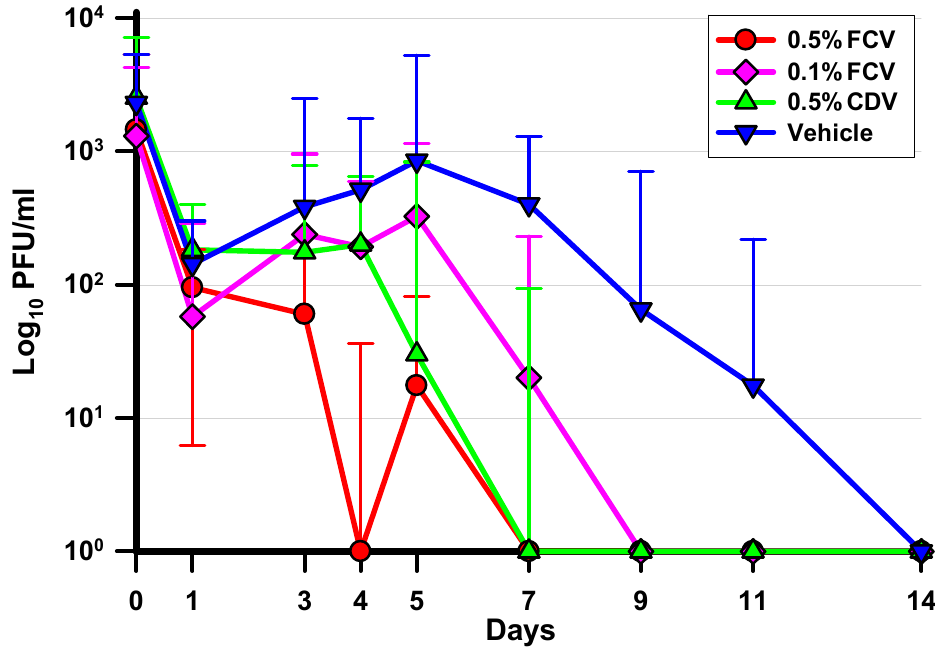
Figure 5. Log 10 median ± interquartile ranges of HAdV5 titers for each treatment group and cul- ture day. Significant differences were shown on the following days: Day 1: (0.5% FCV <